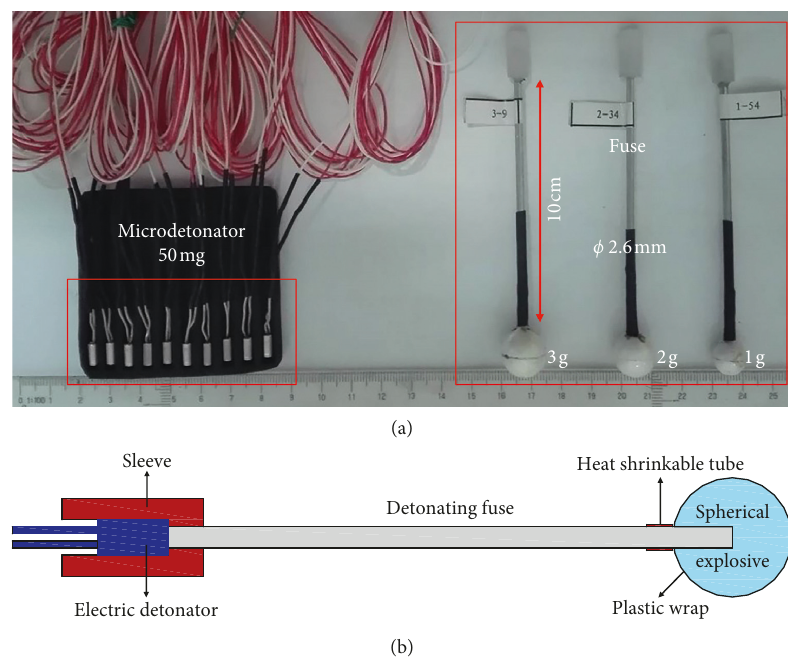
Figure 3: Microdetonators and RDX spherical